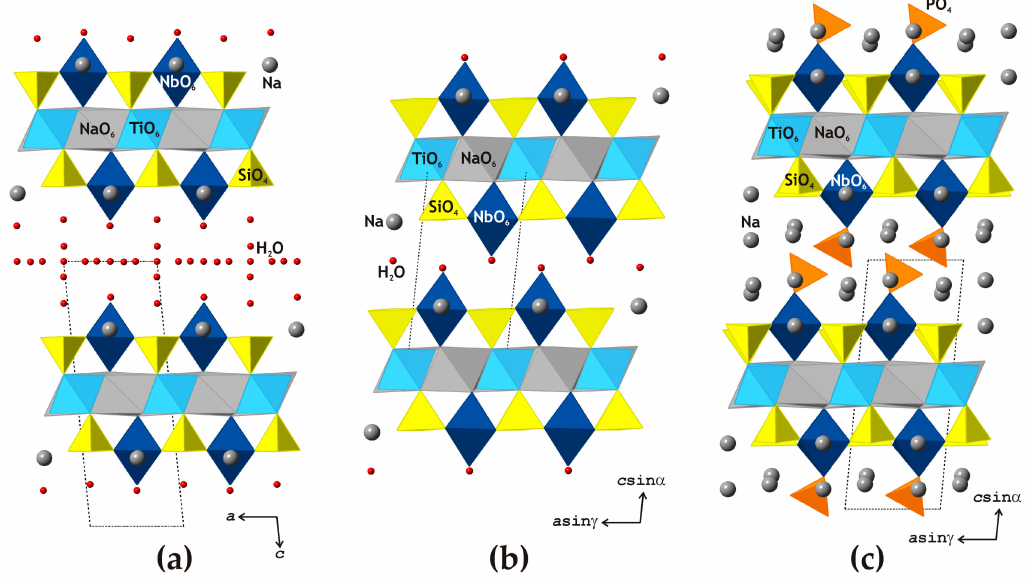
Figure 3. The crystal structures of shkatulkalite ( a ); epistolite ( b ) and vuonnemite ( c ) projected along the b axes. Legend: Nb, Ti, P, Na, and Si polyhedra are shown in dark-blue, light-blue, orange, gray and yellow colors, respectively. Interlayer Na and H 2 O sites are shown as gray and red spheres,